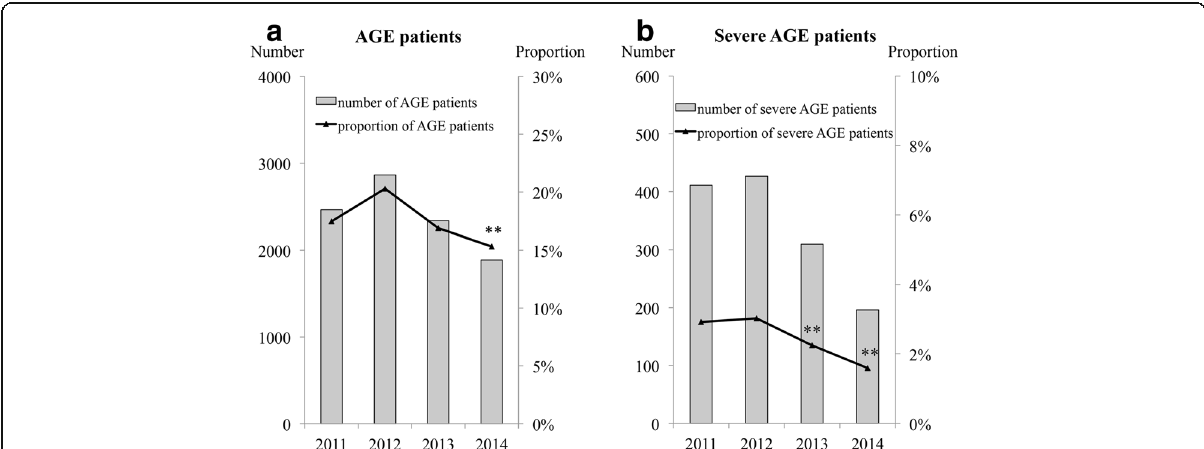
Fig. 2 Numbers and proportions of a AGE and b severe AGE patients ≤ 2 years of age. Gray columns indicate the numbers of AGE or severe AGE patients ≤ 2 years of age in the full season each year. The line indicates the proportions of AGE or severe AGE patients based on the total number